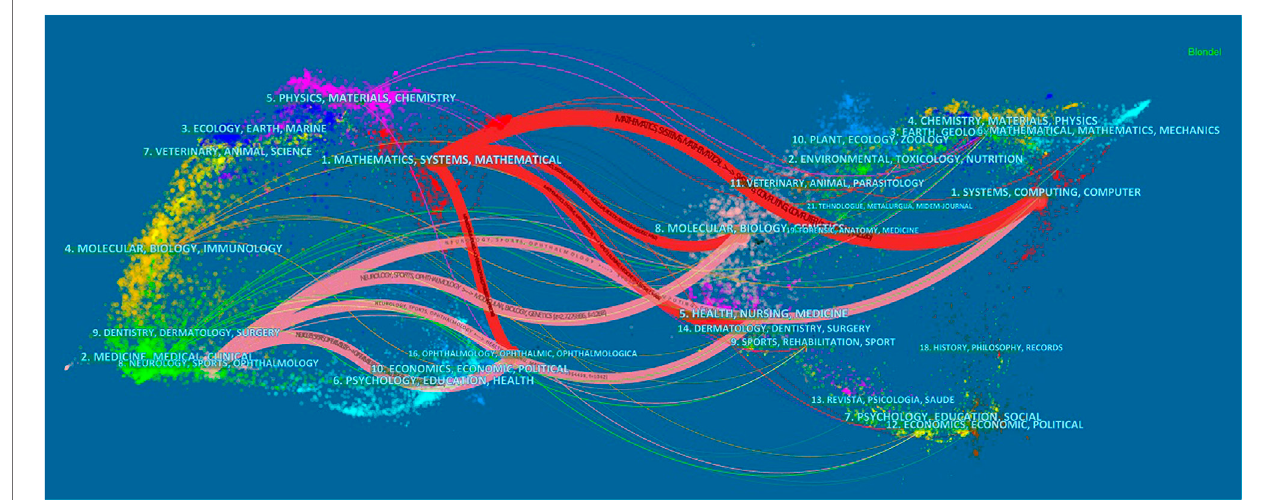
FIGURE 5 | Dual map overlay of journals that contributed to publications on the use of AI in the diagnosis of ophthalmic diseases from 2012 to 2021.